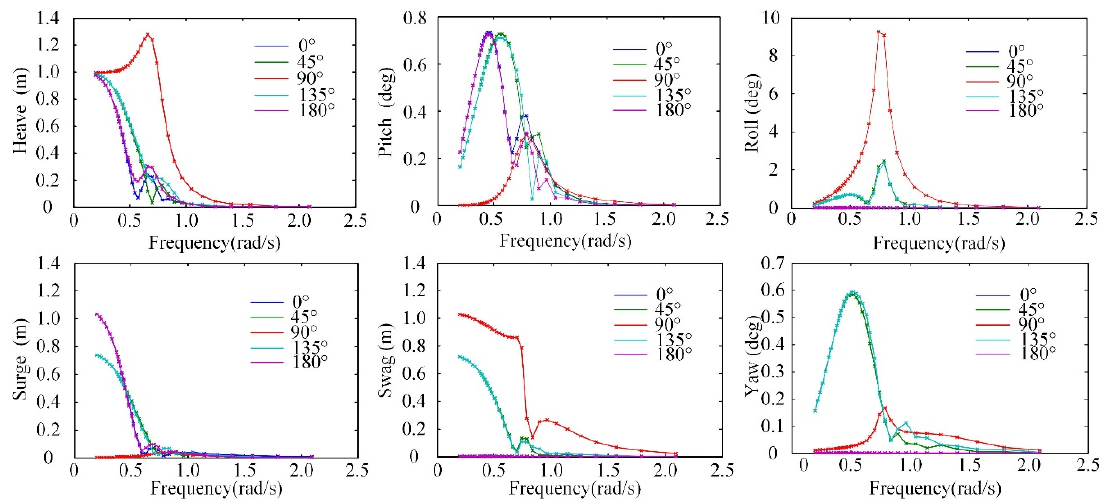
Figure 6. Vessel amplitude response operator (RAO) response.